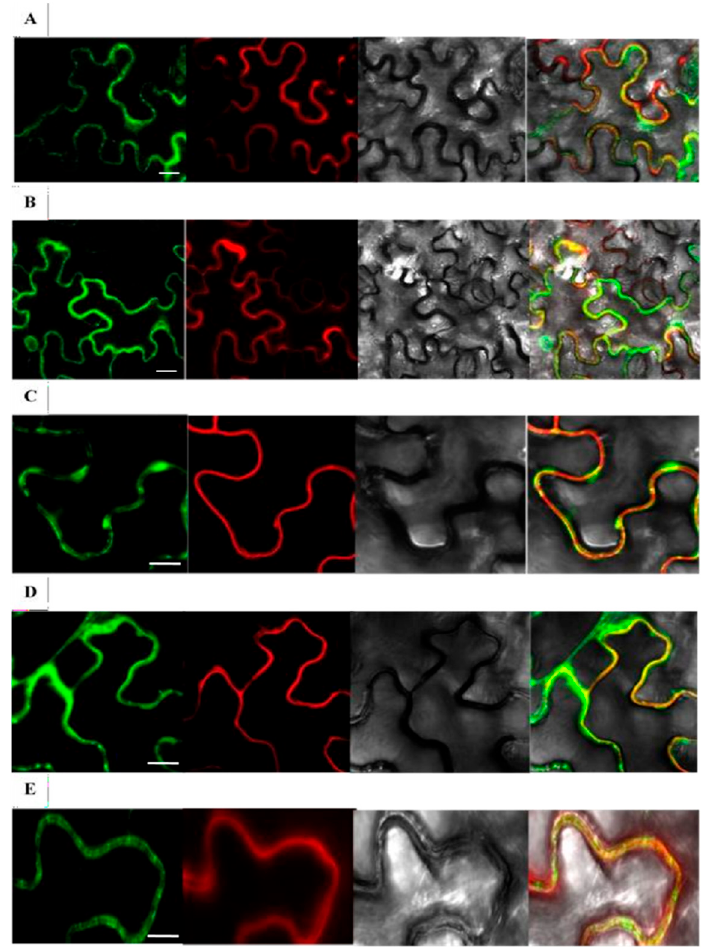
Figure 2. Subcellular localization of rice GH1 At/Os7 proteins in tobacco epithelial cells. Os4BGlu9-GFP, Os4BGlu10-GFP, Os4BGlu11-GFP, Os4BGlu2-GFP and Os4BGlu13-GFP co-infiltrated with RFP-KOR1 were transiently expressed in N. ben- thamiana leaves. The Arabidopsis Korrigan1 (AT5G49720) gene expression construct pCaMV35S:RFP-KOR1 was co-infil- trated into the leaves with pCaMV35S:Os4BGlu9-GFP ( A ), pCaMV35S:Os4BGlu10GFP ( B ), pCaMV35S:Os4BGlu11-GFP ( C ), pCaMV35S: Os4BGlu12- GFP ( D ) and pCaMV35S:Os4BGlu13-GFP ( E ). At 3-4 days after infiltration, the epidermal cells were plasmolyzed by infiltrating 0.8 M mannitol. Microscope images were captured at 10 min after the infiltration of leaves with mannitol by confocal scanning microscopy. For each gene, the images are from left to right: GFP fluorescence, RFP fluorescence, light microscopy, and merged images. Bars = 30 µm ( A , B ), 15 µm ( C – E